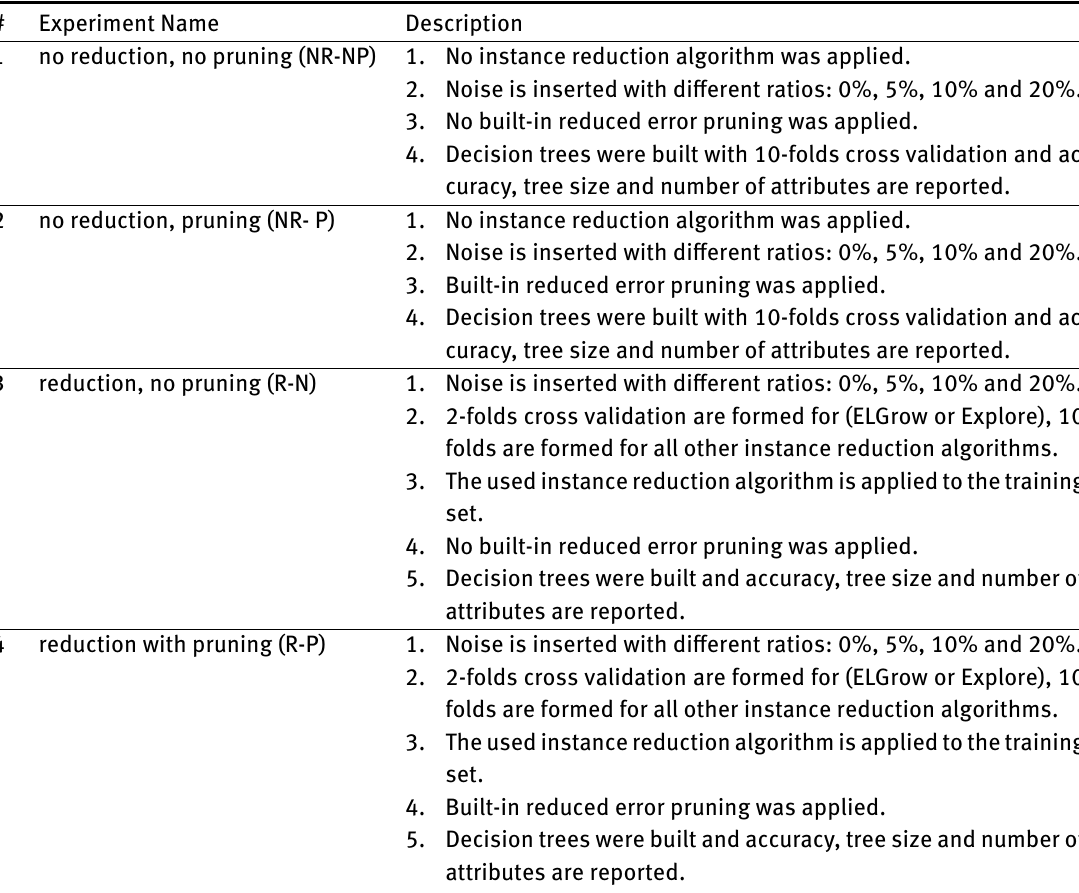
Table 2: Description of the Conducted